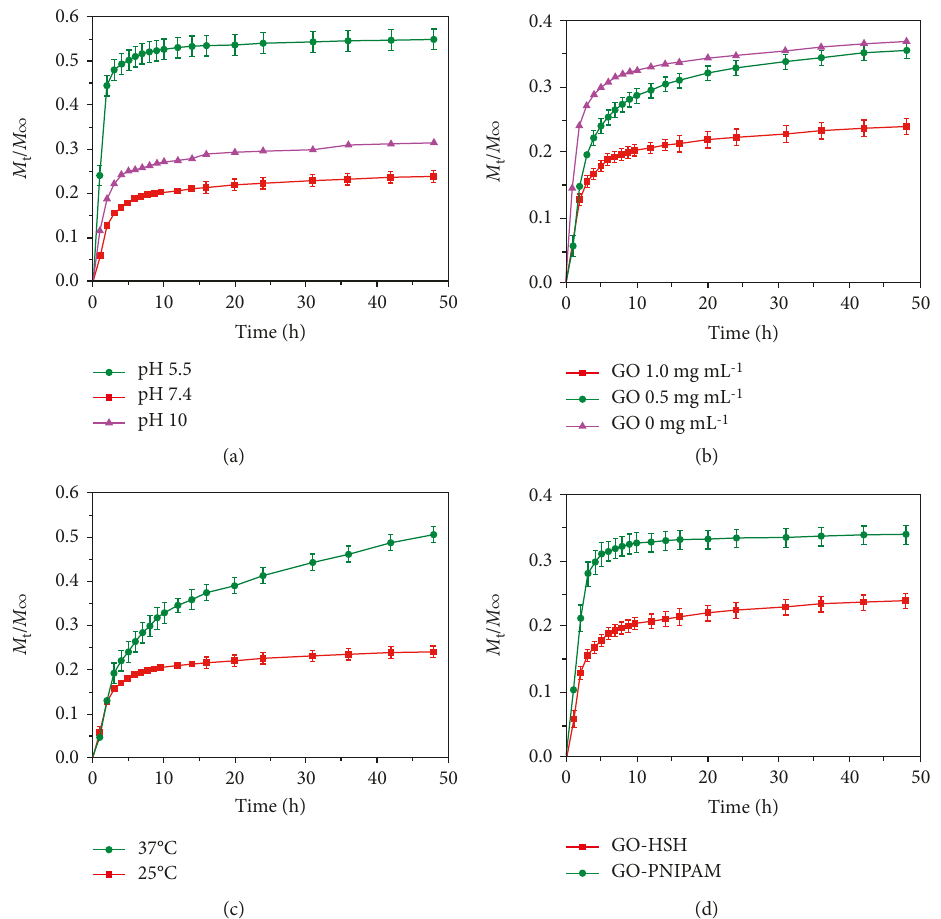
Figure 6: Stimuli-responsive release behavior of DOX from the GO-HSH hydrogel. (a) pH 5.5, pH 7.4, and pH 10 medium at 37 ° C; (b) varied concentrations of GO nanosheets at 37 ° C and (c) at 25 and 37 ° C; (d) DOX release curves of the GO-HSH and GO – PNIPAM hydrogels at 37 ° C